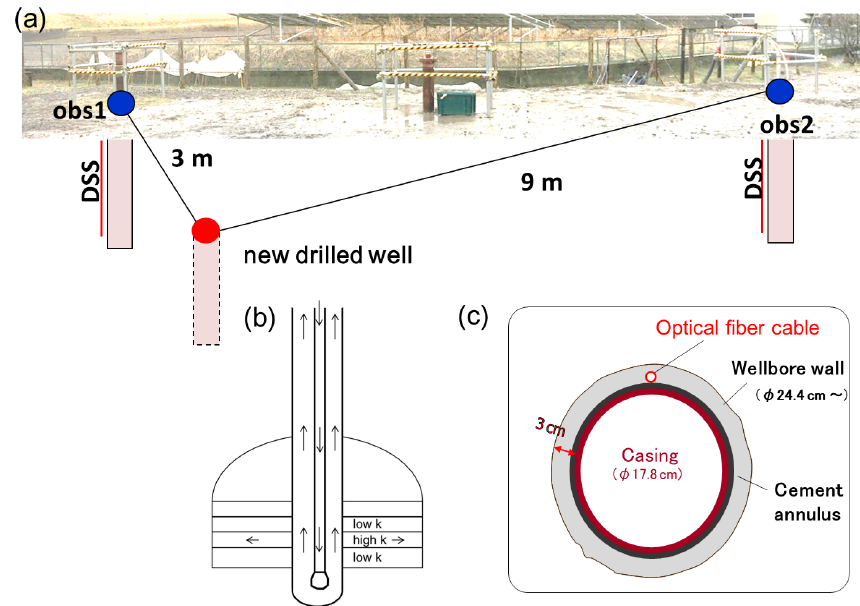
Figure 2. (a) Well pattern for wells obs1 and obs2, in which optical fibers were installed, and the new drilled well; (b) schematic of the drilling fluid invading the reservoir formation; and (c) axial cross section of the well showing the area behind the casing installation of optical fiber cable.